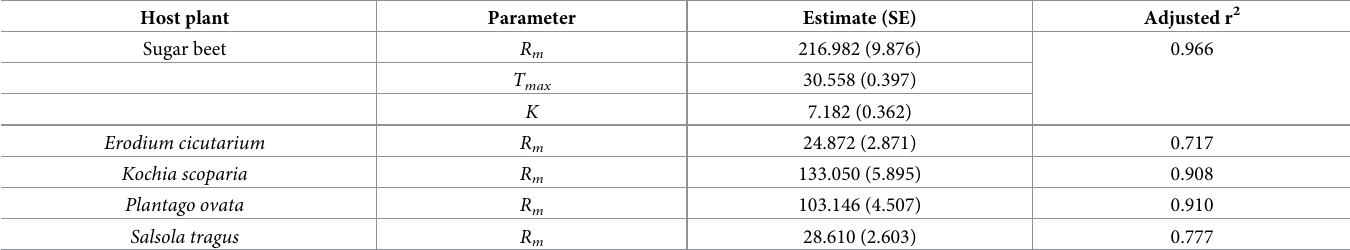
Table 2. Estimated parameters in total fecundity models of female beet leafhoppers on five host plant species. Host plant